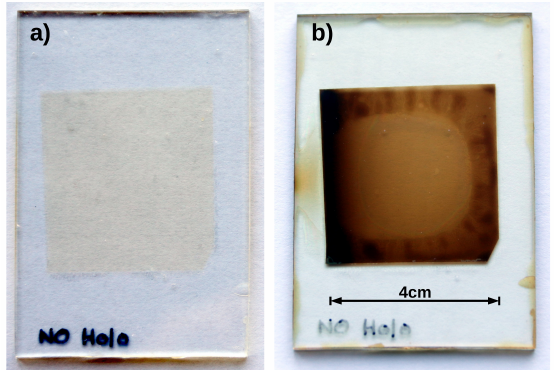
Figure 5. Pictures of the sample before thermal treatment ( a ), and after 12 h at 262 ◦ C ( b